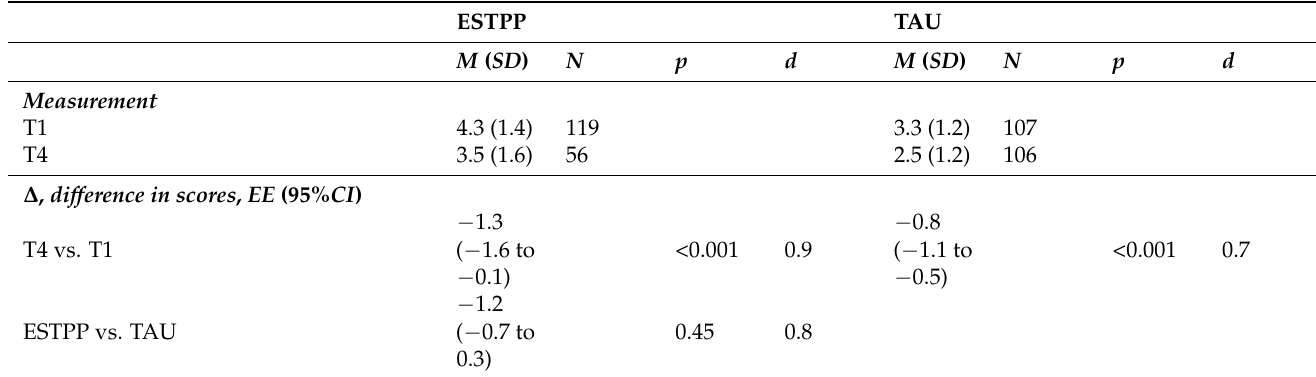
Table 4. Intervention effects on psychological